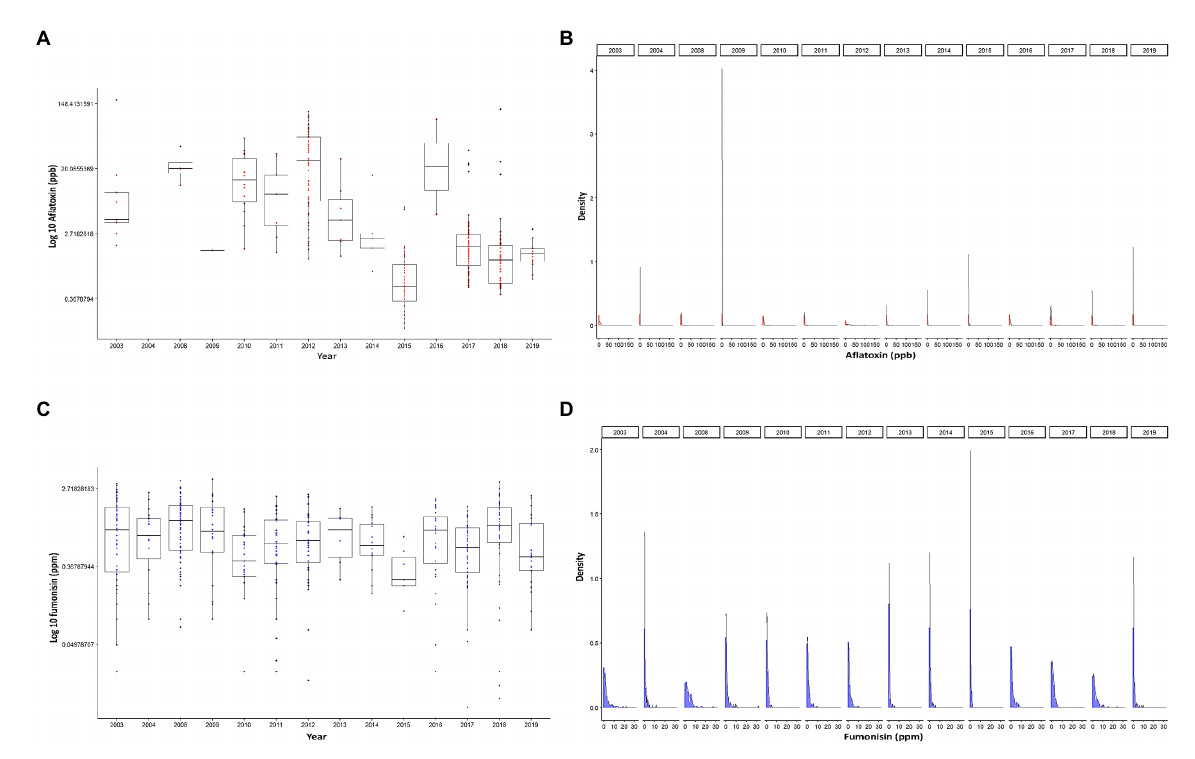
FIGURE 1 Distribution of mycotoxin contamination in Illinois. (A) Logarithmic base 10 scale of accumulation of AFL by year. (B) Density plots of logarithmic base 10 plus one of accumulation of AFL, faceted by year. (C) Logarithmic base 10 scale of accumulation of FUM by year. (D) Density plots of logarithmic base 10 plus one of accumulation of FUM, each panel represents a year. Red color depicts AFL, and blue color depicts FUM. Box-plot whiskers depict the maximum and minimum without outliers, and the box depicts median, first and third quantiles